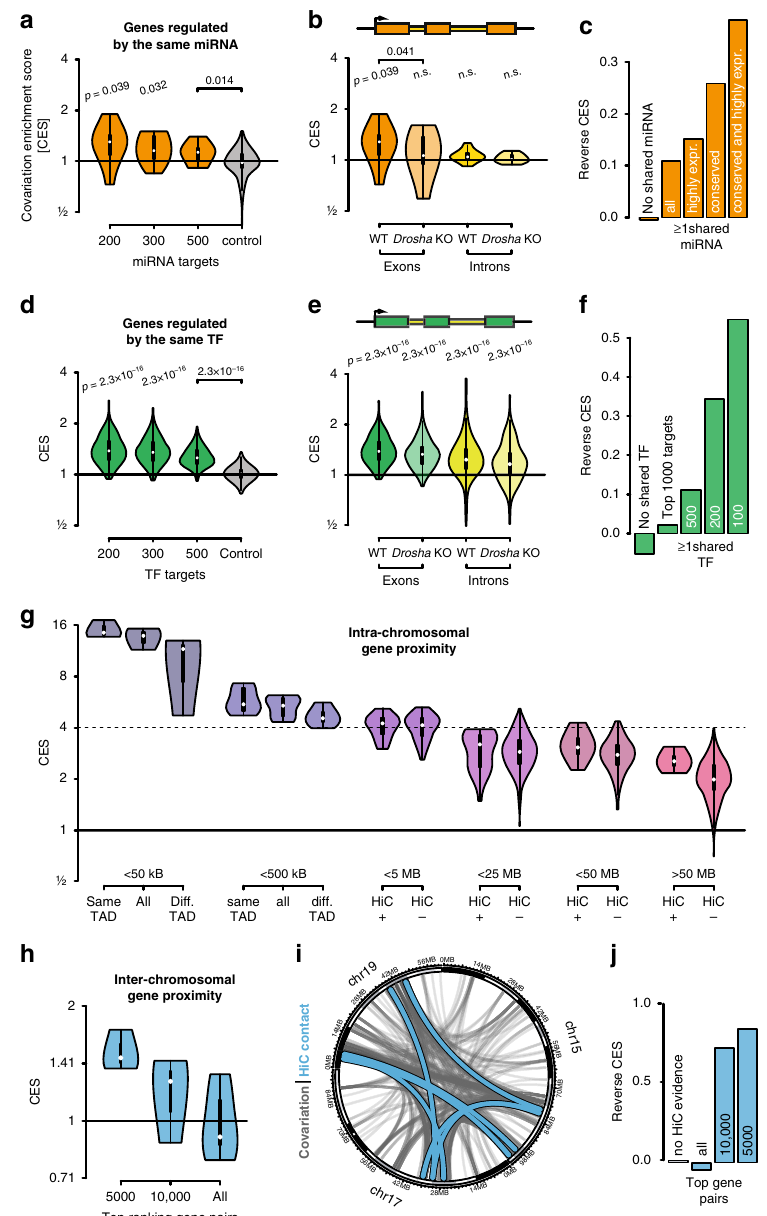
Fig. 2 miRNAs, transcription factors and nuclear organization de fi ne covariations. a miRNA targets tend to covary. Covariations enrichment scores (CES) for the top 200, 300, and 500 ranked miRNA targets according to TargetScan, for the seven highest expressed conserved miRNA and for a control set for comparison for 500 randomly selected targets. p -values refer to respective controls. b miRNA target covariations occur post-transcriptionally and are miRNA-dependent. Enrichment in sets of the top 200 ranked miRNA targets in parental cells (WT) and Drosha KO cells, that are void of canonical miRNAs. Enrichments are color coded for exonic reads, representing post-transcriptional regulation (orange) or intronic reads representing transcriptional regulation (yellow). c Covarying genes are enriched for shared miRNA targeting. Reverse covariation enrichment shows the log2 ratio between covariations that share a common miRNA and permuted covariations that share a common miRNA. d Transcription factor targets are enriched for gene covariations. Enrichment in sets of the top 200, 300, and 500 transcription factor targets, for 145 transcription factors pro fi led with ChIP-seq. Control for comparison is shown for 500 randomly selected targets. p -values refer to respective controls. e Transcription factor target covariations are transcriptional and miRNA- independent. Enrichment in sets of the 200 ranked transcription factor targets in parental cells (WT) and Drosha KO cells. Enrichments are color coded for exonic reads (dark green) or intronic reads (light green). f Covarying genes are enriched for shared transcription factor targeting ( fi gure similar to c). g Genes that are in close nuclear proximity and locate to the same chromosome are enriched for covariations. The range categories are mutually exclusive, for instance pairs of genes that are <5 MB apart are not included in the <25 MB category. h Gene regions that are in close nuclear proximity and locate to different chromosomes are enriched for covariations. Since relatively few intrachromosomal Hi-C contacts were identi fi ed, we here used a less stringent criteria ( p -value <0.05) cut-off to robustly identify signi fi cant covariations. i Circos plot showing signi fi cant covariations and Hi-C contacts for chromosomes 15, 17, and 19. Signi fi cantly covarying gene pairs are connected by a light blue line. Inter-chromosomal Hi-C contacts are shown as gray lines. j Covarying genes are enriched for interchromosomal Hi-C contacts ( fi gure similar to c). a , b , d , e All p -values represent two-sided independent two-group t -tests between targets sets and respective controls (see “ Methods ”